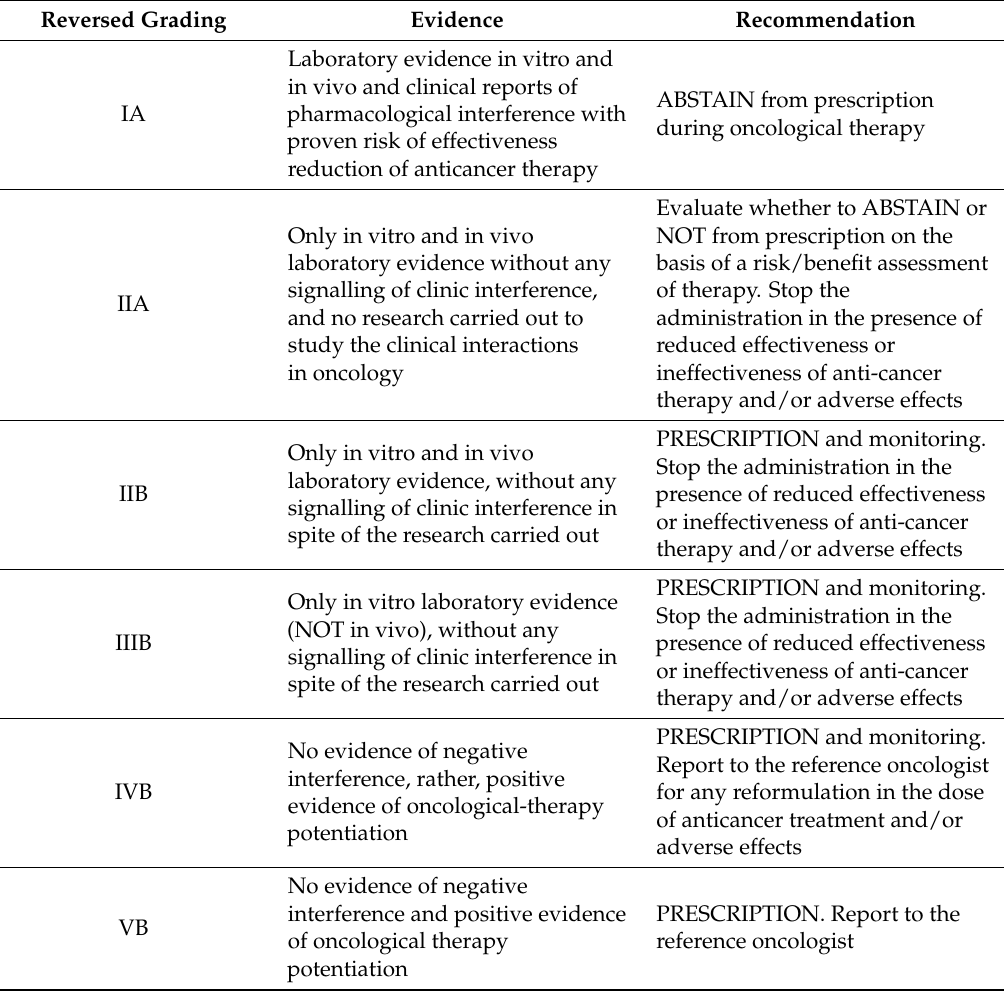
Table 1. Reversed Grading. I–V grade of evidence correlated to risk. A (Abstain), B (Prescription). Reversed